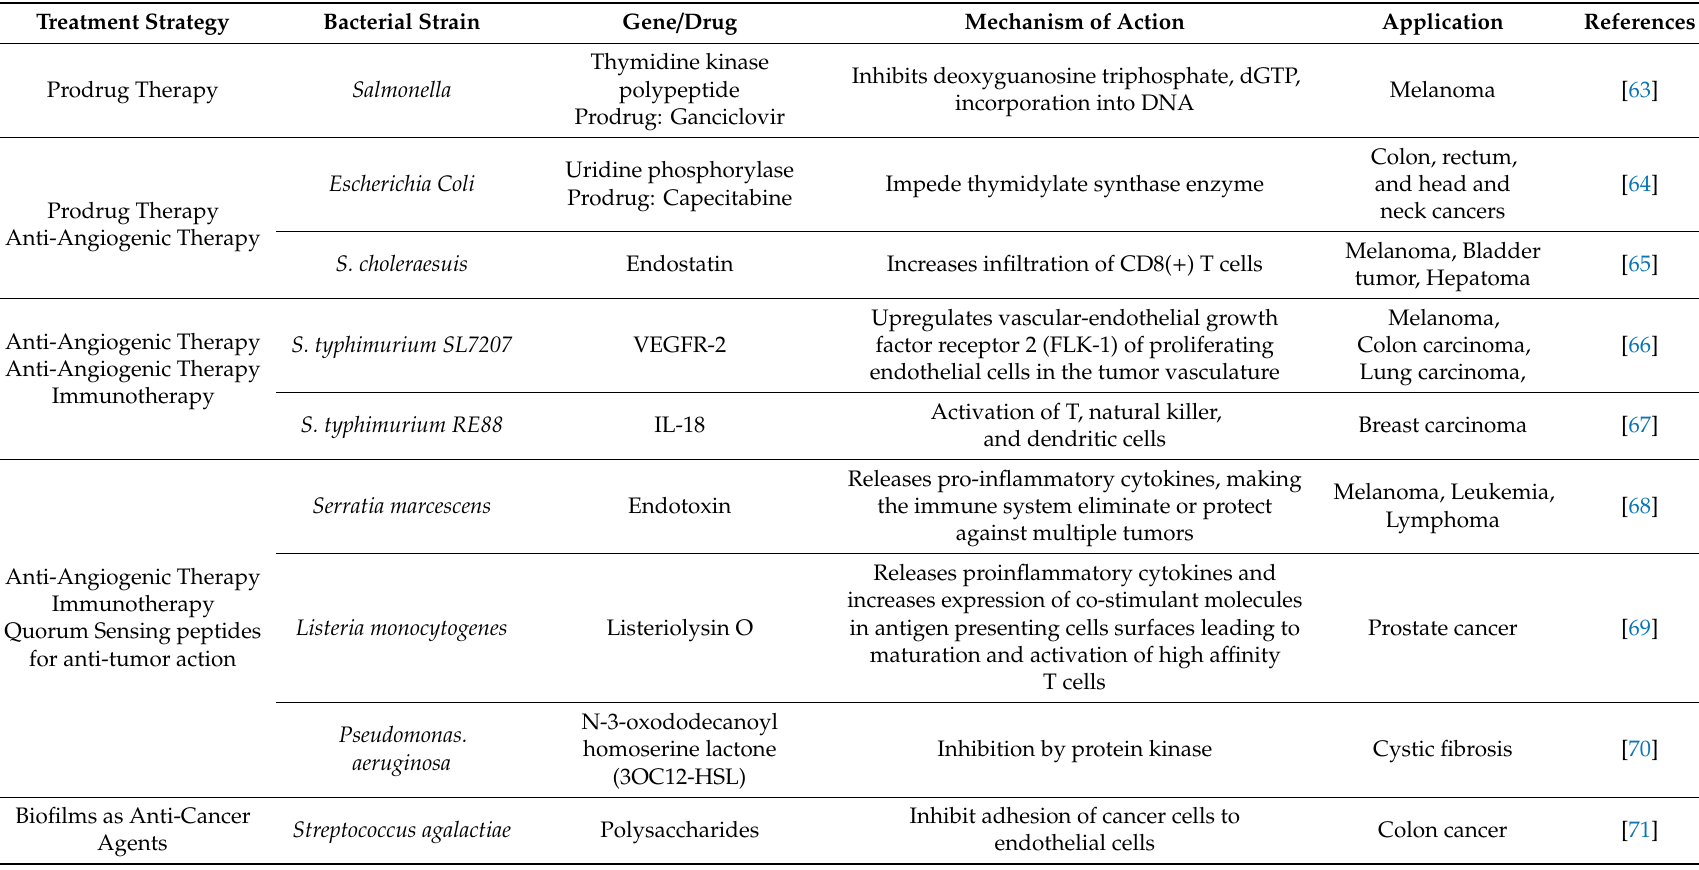
Table 2. Applications of genetically engineered bacteria as vectors for anti-cancer